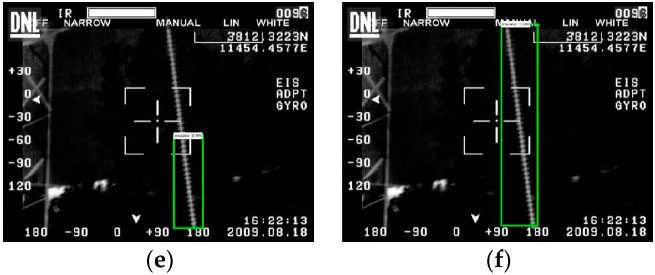
Figure 8. Detection results of insulators with different aspect ratios. ( a , c , e ) Results obtained by traditional RPN; ( b , d , f ) results obtained by improved RPN.